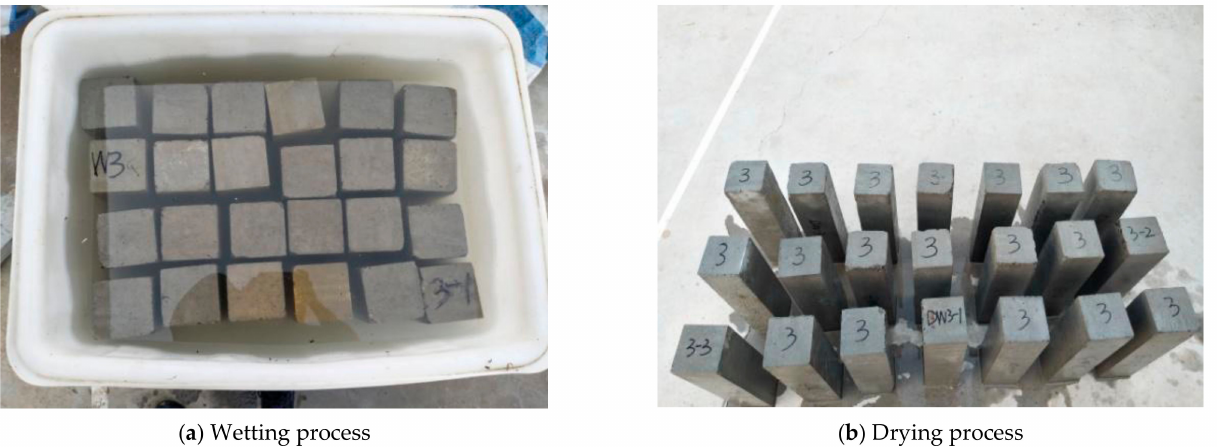
Figure 3. Wetting and drying process. ( a ) Wetting process; ( b ) drying